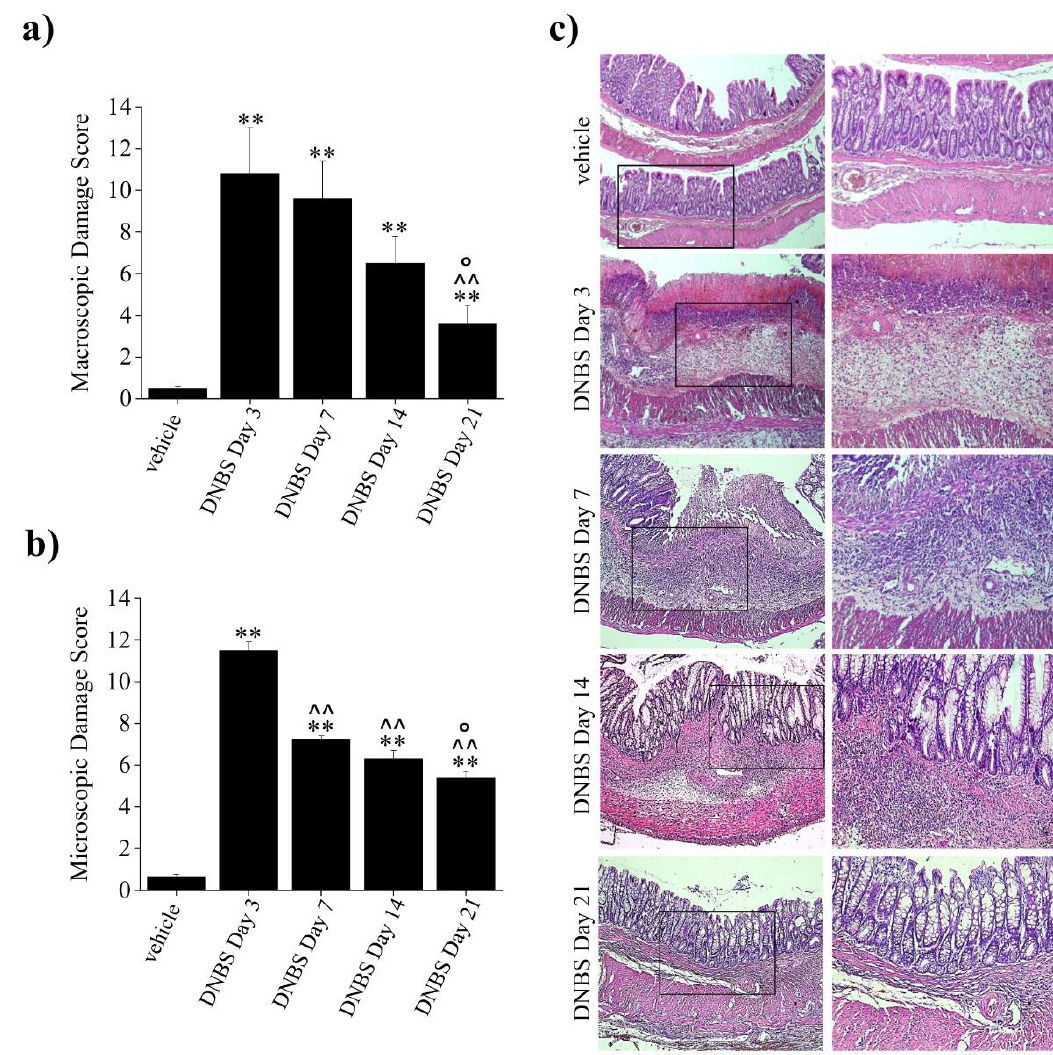
Figure 2. Histological evaluation of colonic damage at different time points after DNBS injection. ( a ) Macroscopic damage score; ( b ) microscopic damage score; ( c ) representative pictures of hematoxylin/eosin-stained sections of full-thickness colon. Original magnification: 5× (left column), 10× (right column). Each value represents the mean ± SEM of 8 animals per group. ** p < 0.01 vs. vehicle-treated animals. ^^ p < 0.01 vs. DNBS day 3 treated animals. ° p < 0.05 vs. DNBS day 7 treated animals.